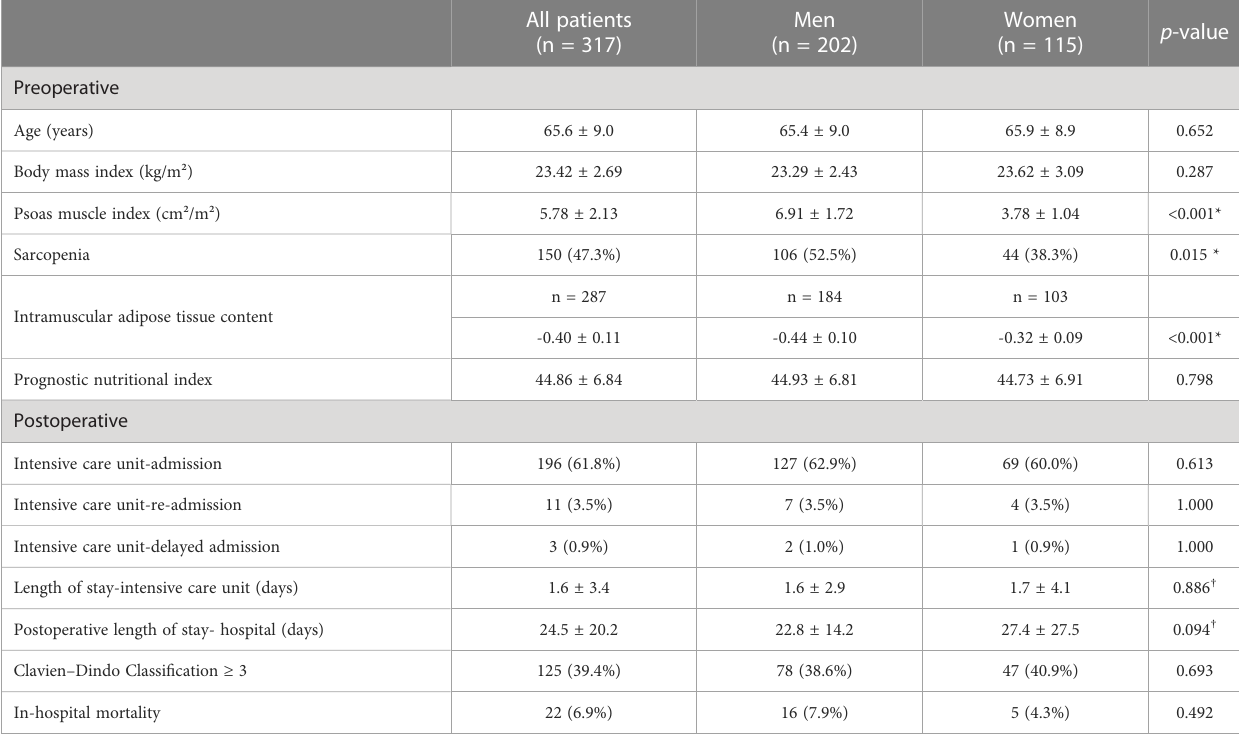
TABLE 1 Demographic and clinical characteristics of patients with Klatskin tumors who underwent hepatic resection.